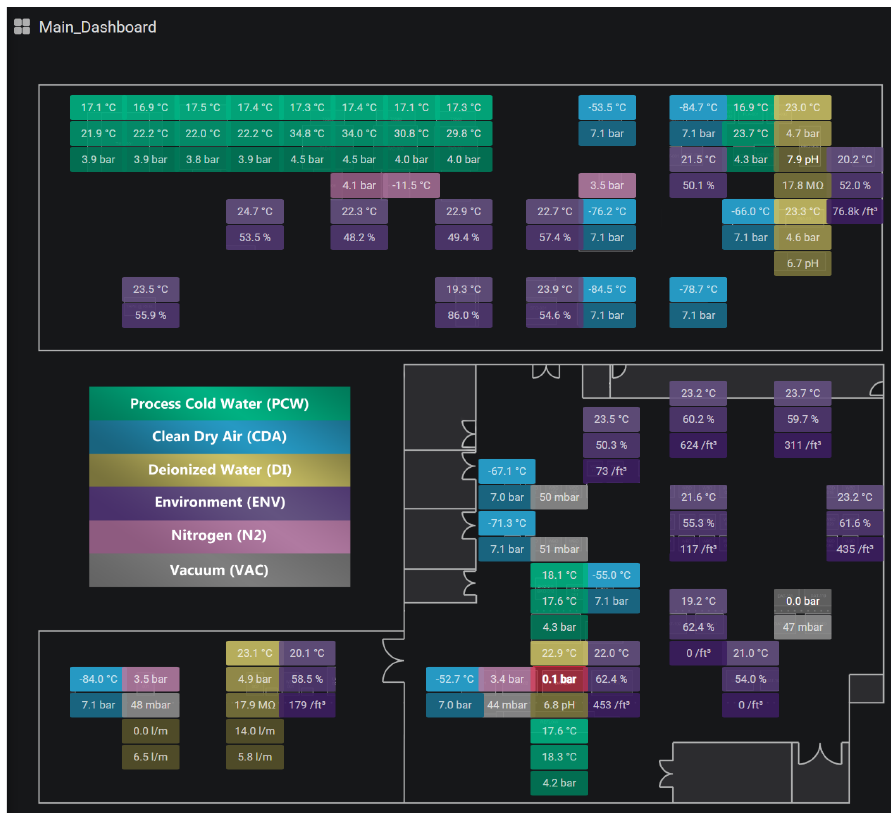
Figure 4. Map of the plant in Grafana. Figure 6. Using the visualization tool to map and analyze the state of the sensors in the industrial plant.